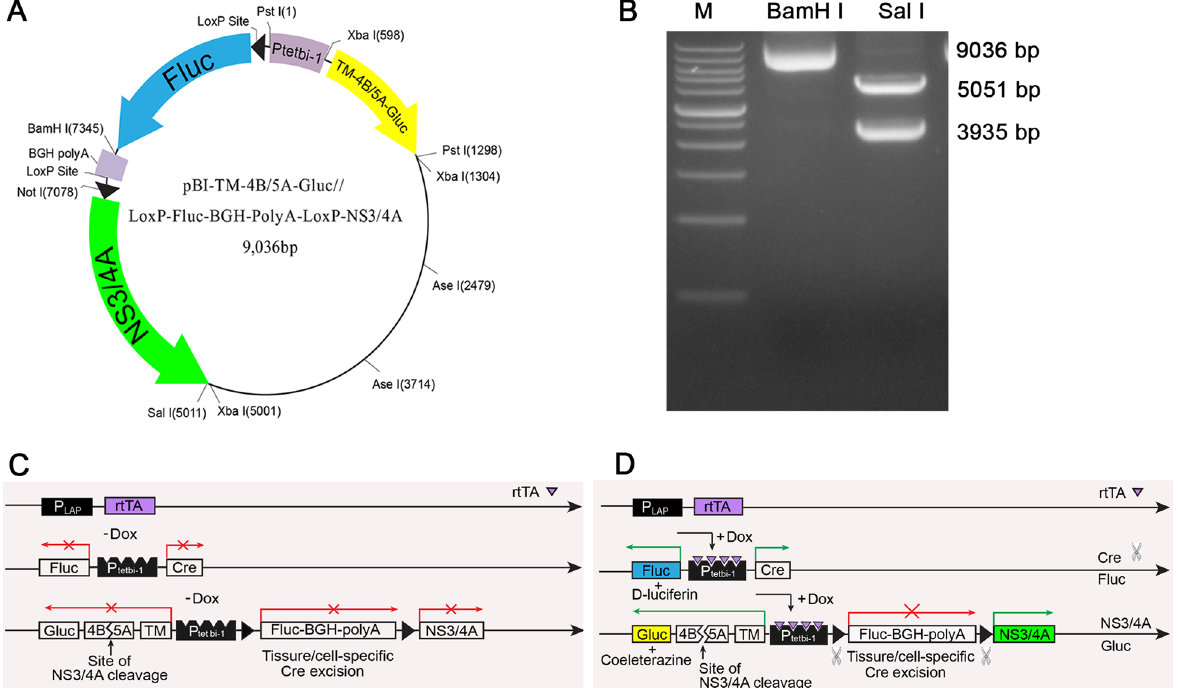
Fig 1. Schematic overview of the created conditional inducible triple-transgenic mouse model for rapid real-time detection of HCV NS3/4A protease activity. (A) The pBI-NS3/4A transgenic vector. (B) The pBI-NS3/4A vector was digested with Bam HI and Sal I and submitted to gel electrophoresis to confirm the correct construction. M: 500 – 12,000 bp. (C) Construction of the pTet-On-rtTA , pBI-Cre and pBI-NS3/4A plasmids. rtTA is expressed under the Lap promoter, but without Dox induction, rtTA is unable to bind to P tet bi-1 to provide temporal control of gene expression. (D) Schematic overview of the created triple-transgenic mouse model for rapid real-time assessment of HCV NS3/4A protease activity. In the presence of Dox, rtTA binds to the P tet bi-1 sequence on the pBI-Cre and pBI-NS3/4A vectors and activates transcription of the Cre and Fluc genes in pBI-Cre . Cre-mediated removal of the Fluc-BGH-PolyA STOP cassette leads to NS3/4A expression from the pBI-NS3/4A plasmid. The NS3/4A protease then cleaves at the 4B5A junction, resulting in the secretion of Gluc into either culture medium or blood. TM, C-terminal transmembrane domain; BGH, bovine growth hormone.